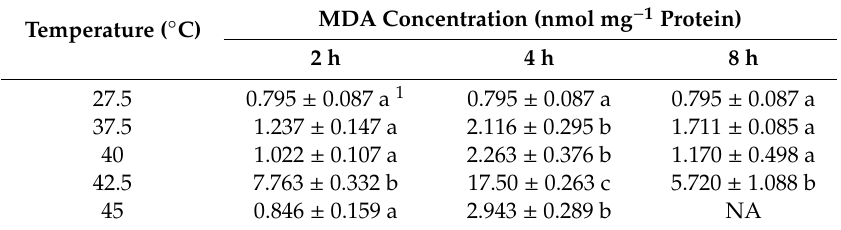
Table 2. Malondialdehyde (MDA) concentration ( ± standard error (SE)) (nmol mg − 1 protein) of Liposcelis bostrychophila exposed to heat shock